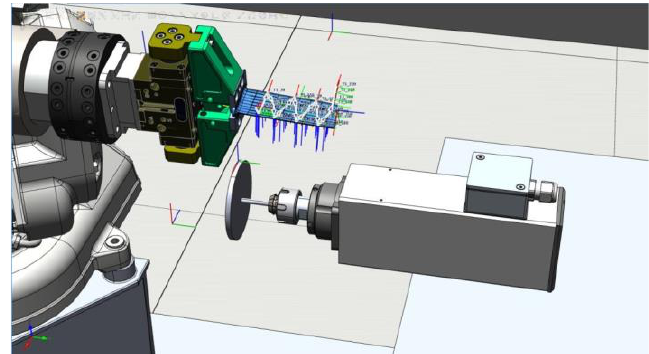
Figure 15. Application view in RobotStudio.